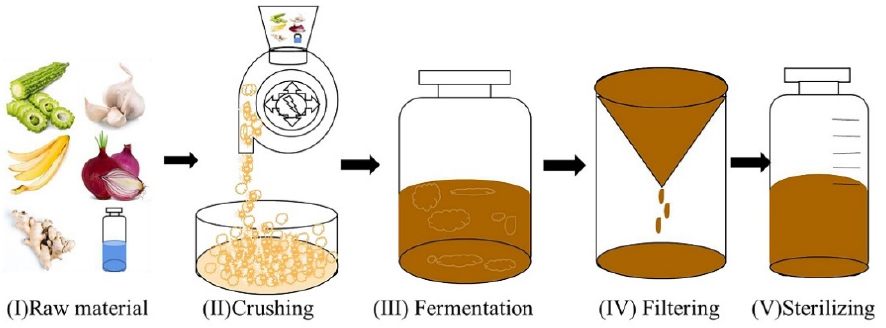
Figure 1. Drug preparation flow chart of Ren’s oligopeptides-1.